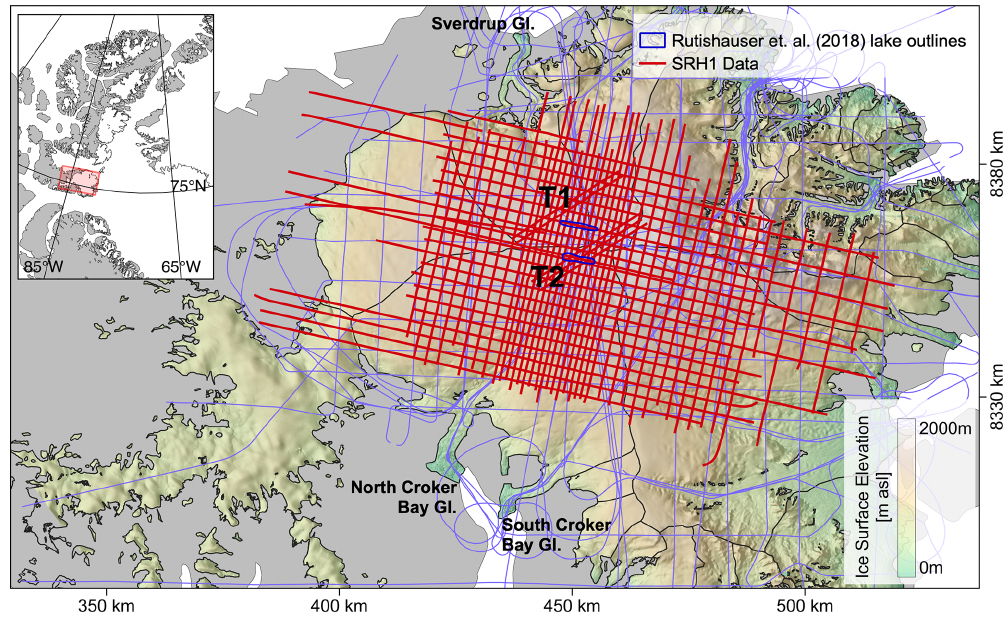
Figure 1. Map of Devon Ice Cap overlain with existing radar datasets collected prior to our survey (blue), including data presented in Dowdeswell et al. (2004) and Rutishauser et al. (2016, 2018), as well as conducted in Operation IceBridge surveys between 2011–2015 (Paden et al., 2019), and the aerogeophysical survey profiles collected in this study (SRH1; red). Blue outlines mark the location of the previously inferred subglacial lakes in bedrock troughs T1 and T2 (Rutishauser et al., 2018), and the thin black lines mark the boundaries of the glacier catchment areas. Background image features the ArcticDEM surface elevation map by the Polar Geospatial Center from DigitalGlobe Inc. imagery (Porter et al.,